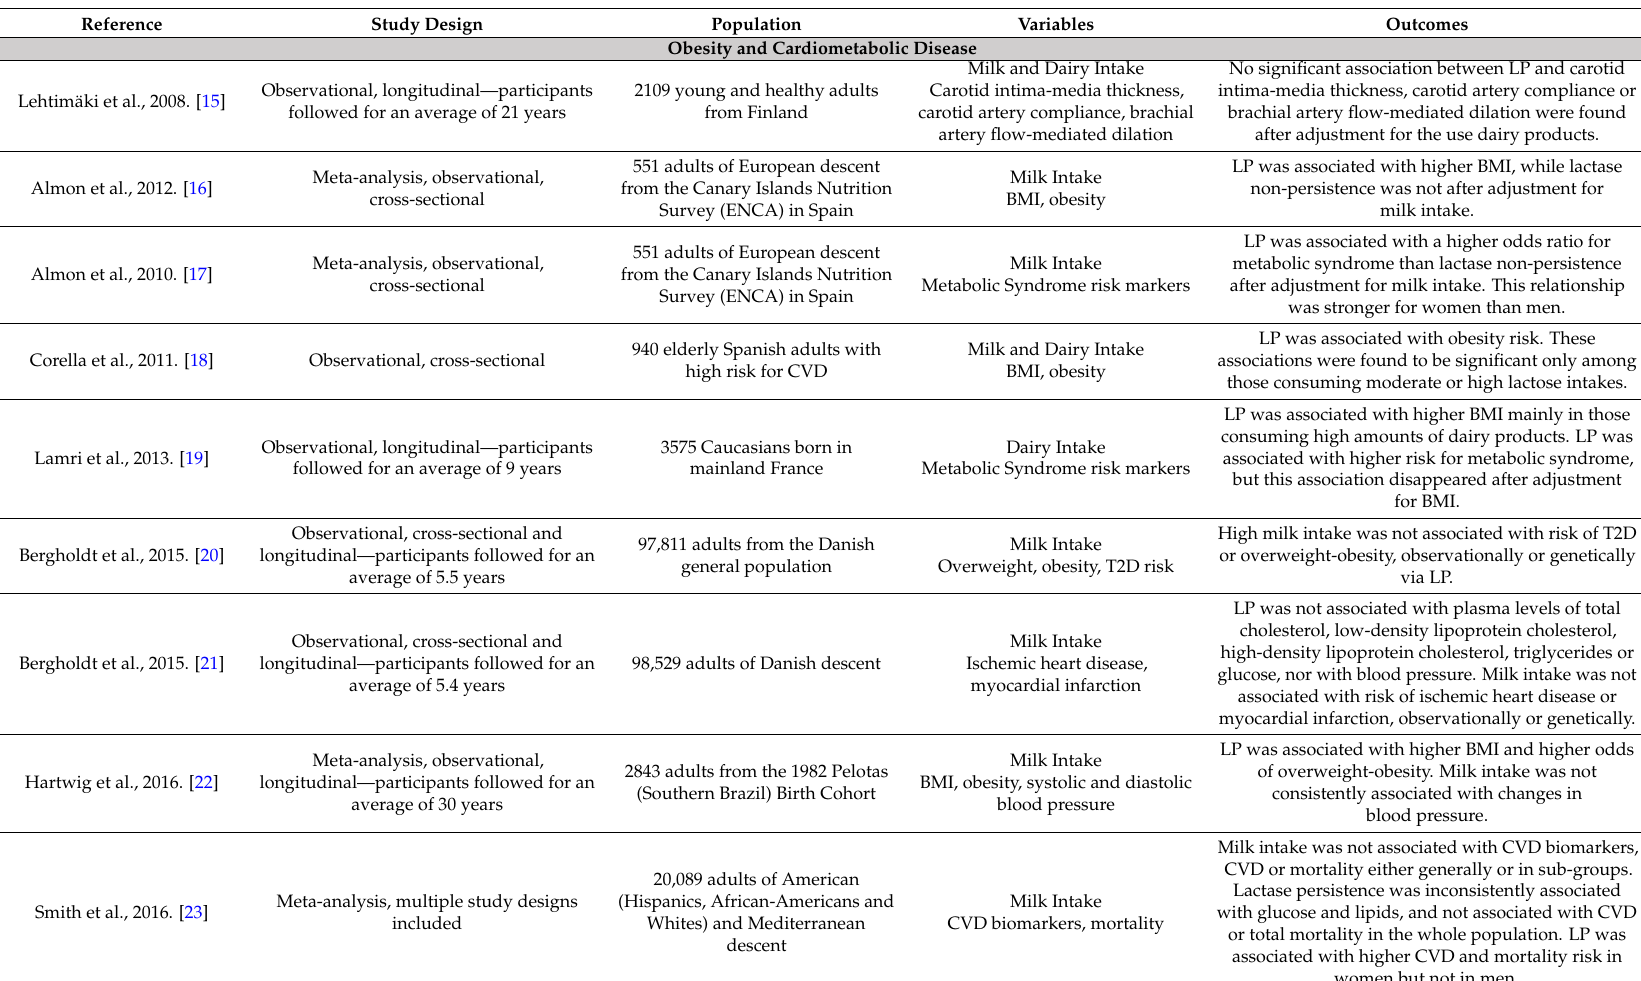
Table 1. Nutrigenetic studies on lactase persistence, dairy intake, and health outcomes in